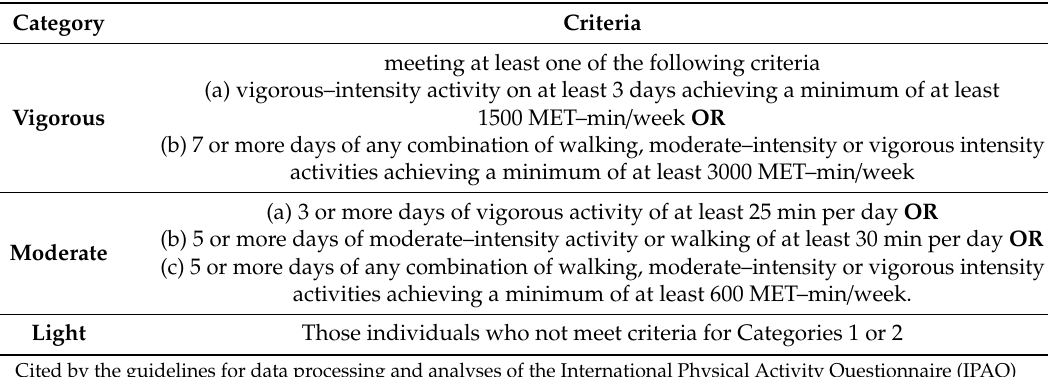
Table A2. The criteria for these three levels of physical